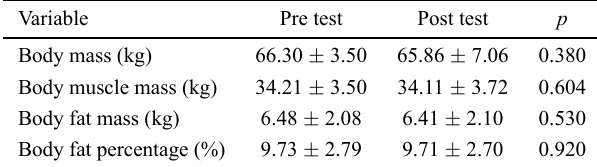
Table 3. Change in body composition (Mean Values ±